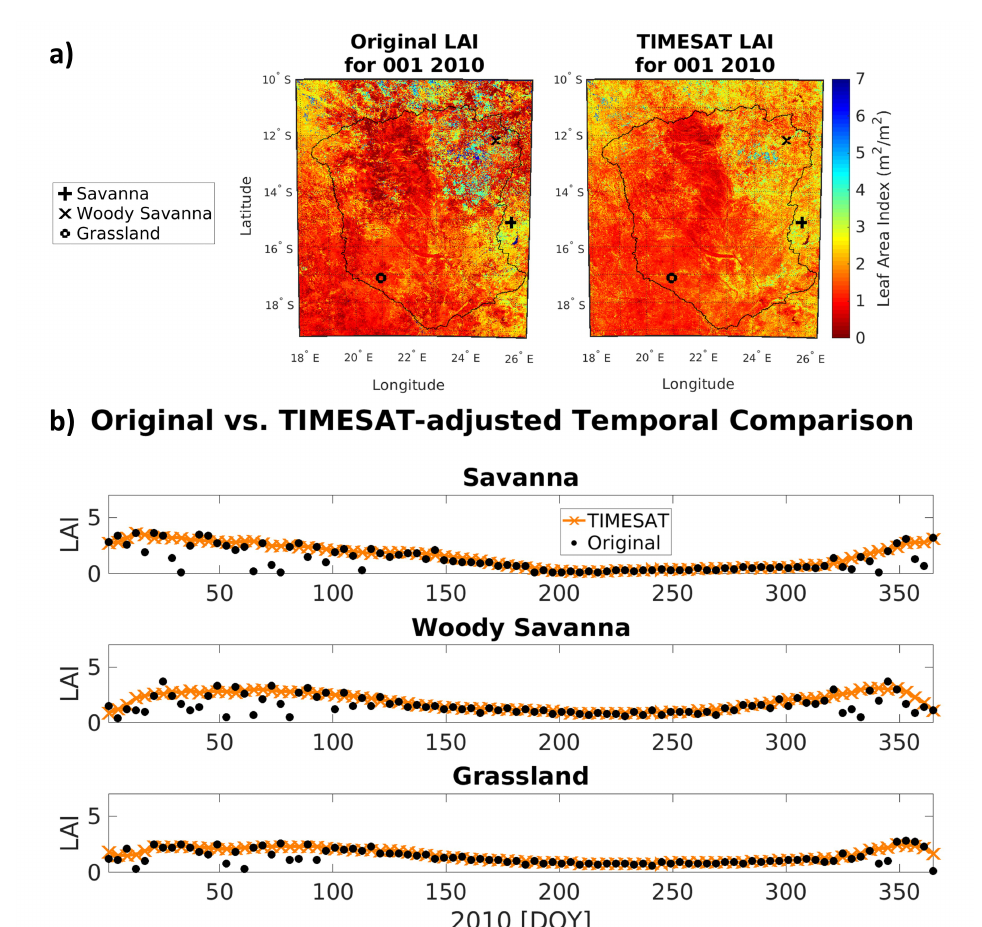
Figure 2. ( a ) Spatial and ( b ) temporal comparisons between 2010 original and new TIMESAT- corrected Leaf Area Index (LAI)